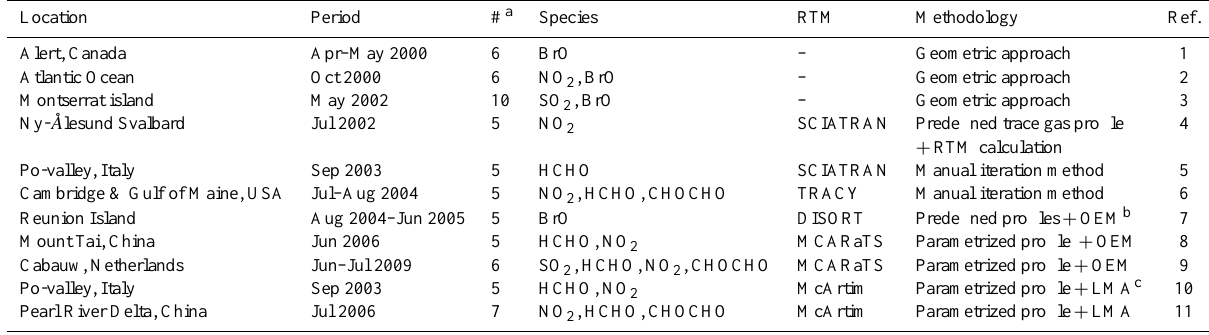
Table 1. Overview of MAX-DOAS trace gas measurements. Location Period # a Species RTM Methodology